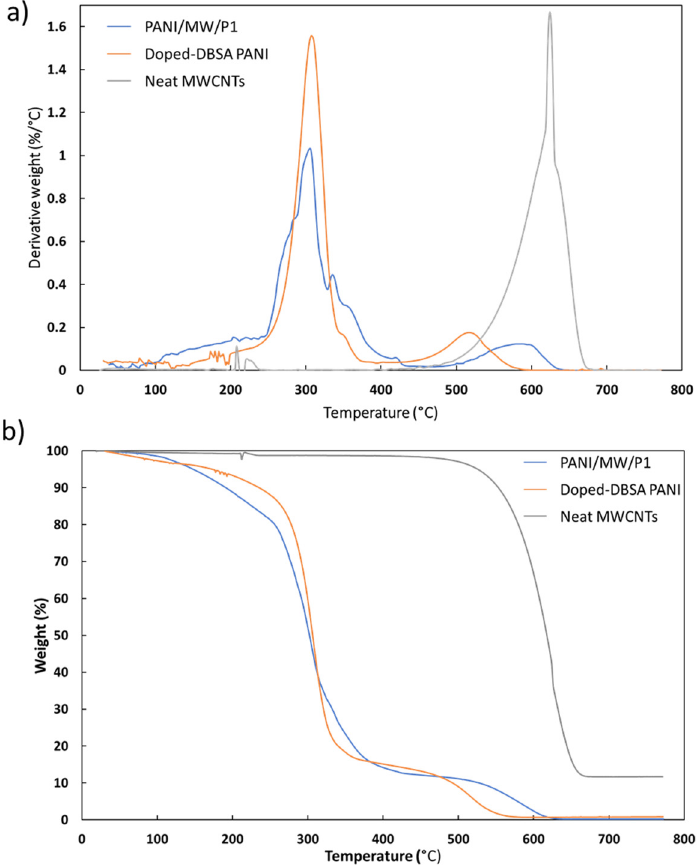
Figure 4. ( a ) DTG and ( b ) TGA thermograms of neat MWCNTs (gray line), doped-DBSA PANI (orange line), and PANI/MW/P1 (blue line).